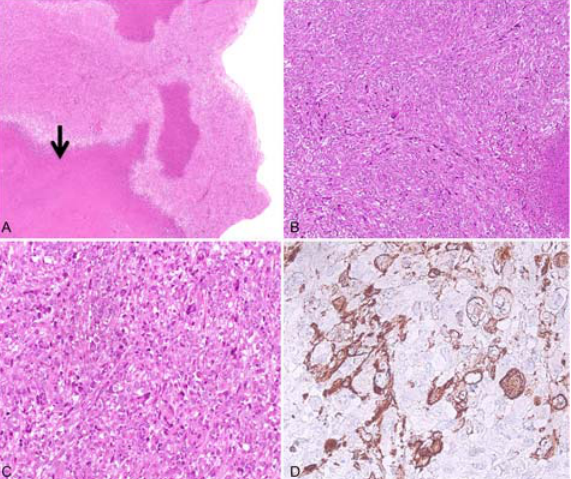
Figure 1. Histological findings representing the osteosarcoma sample. ( A ) Macroscopic aspect of the neoplastic mass formed by solid whitish-gray tissue; ( B , C ) malignant neoplasia forming solid nests or intersecting bundles (100 × ) with areas of necrosis (200 × ), respectively; ( D – G ) proliferation consisting of pleomorphic spindle (200 × ) or rounded cells (200 × ) with areas of chondroid (200 × ) and osteoid matrix (200 × ), respectively; ( H , I ) immunohistochemistry of neoplastic cells diffusely positive for vimentin (400 × ) and focally positive for wide-spectrum cytokeratin (400 × ), respectively. ( B – G ): Hematoxylin–eosin staining.